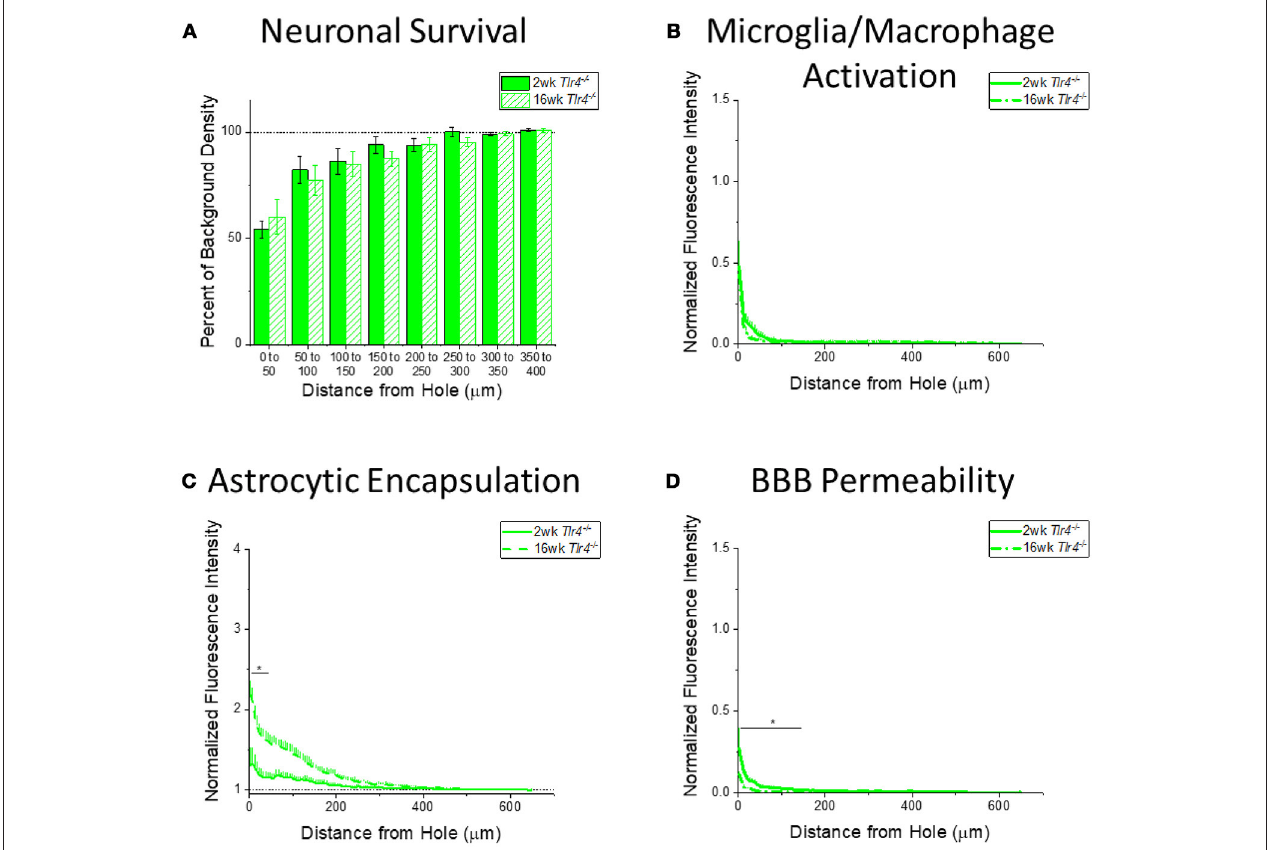
FIGURE 6 | Changes in immunohistochemical markers in Tlr4 − / − mice over time. (A–D) Show immunohistochemical marker expression in Tlr4 − / − mice at 2 and 16 weeks after probe implantation. (A) Neuronal survival displayed as percent of background neuronal density with respect to distance from the probe hole ( µ m). Tlr4 − / − mice exhibit no significant difference in neuronal survival between two and 16 weeks after probe implantation. 2 wk Tlr4 − / − : N = 5; 16 wk Tlr4 − / − : N = 5. (B) Microglia and macrophage activation (CD68) displayed as normalized fluorescence intensity with respect to distance from the probe hole ( µ m). Tlr4 − / − mice exhibit no significant differences in microglia and macrophage activation between time points. 2 wk Tlr4 − / − : N = 4; 16 wk Tlr4 − / − : N = 5. (C) Astrocytic encapsulation (GFAP) displayed as normalized fluorescence intensity with respect to distance from the probe hole ( µ m). Tlr4 − / − mice exhibit significantly higher astrocytic encapsulation at 16 weeks after probe implantation the distance intervals 0–50 µ m from the probe hole, * p < 0.05. 2 wk Tlr4 − / − : N = 4; 16 wk Tlr4 − / − : N = 5. (D) Blood-brain barrier permeability (IgG) as normalized fluorescence intensity with respect to distance from the probe hole ( µ m). Tlr4 − / − mice exhibit significantly higher blood-brain barrier permeability at 2 weeks after probe implantation at the distance intervals 0–50, 50–100, and100–150 µ m from the probe hole, * p < 0.05. 2 wk Tlr4 − / − : N = 4; 16 wk Tlr4 − / − : N =